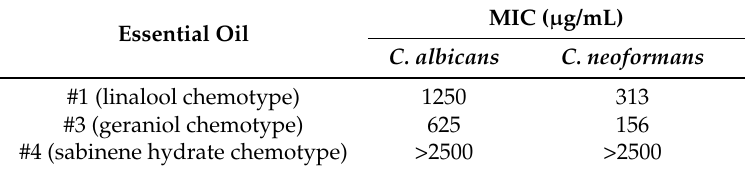
Table 2. Antifungal activities (minimum inhibitory concentrations, MIC) of Thymus vulgaris essential